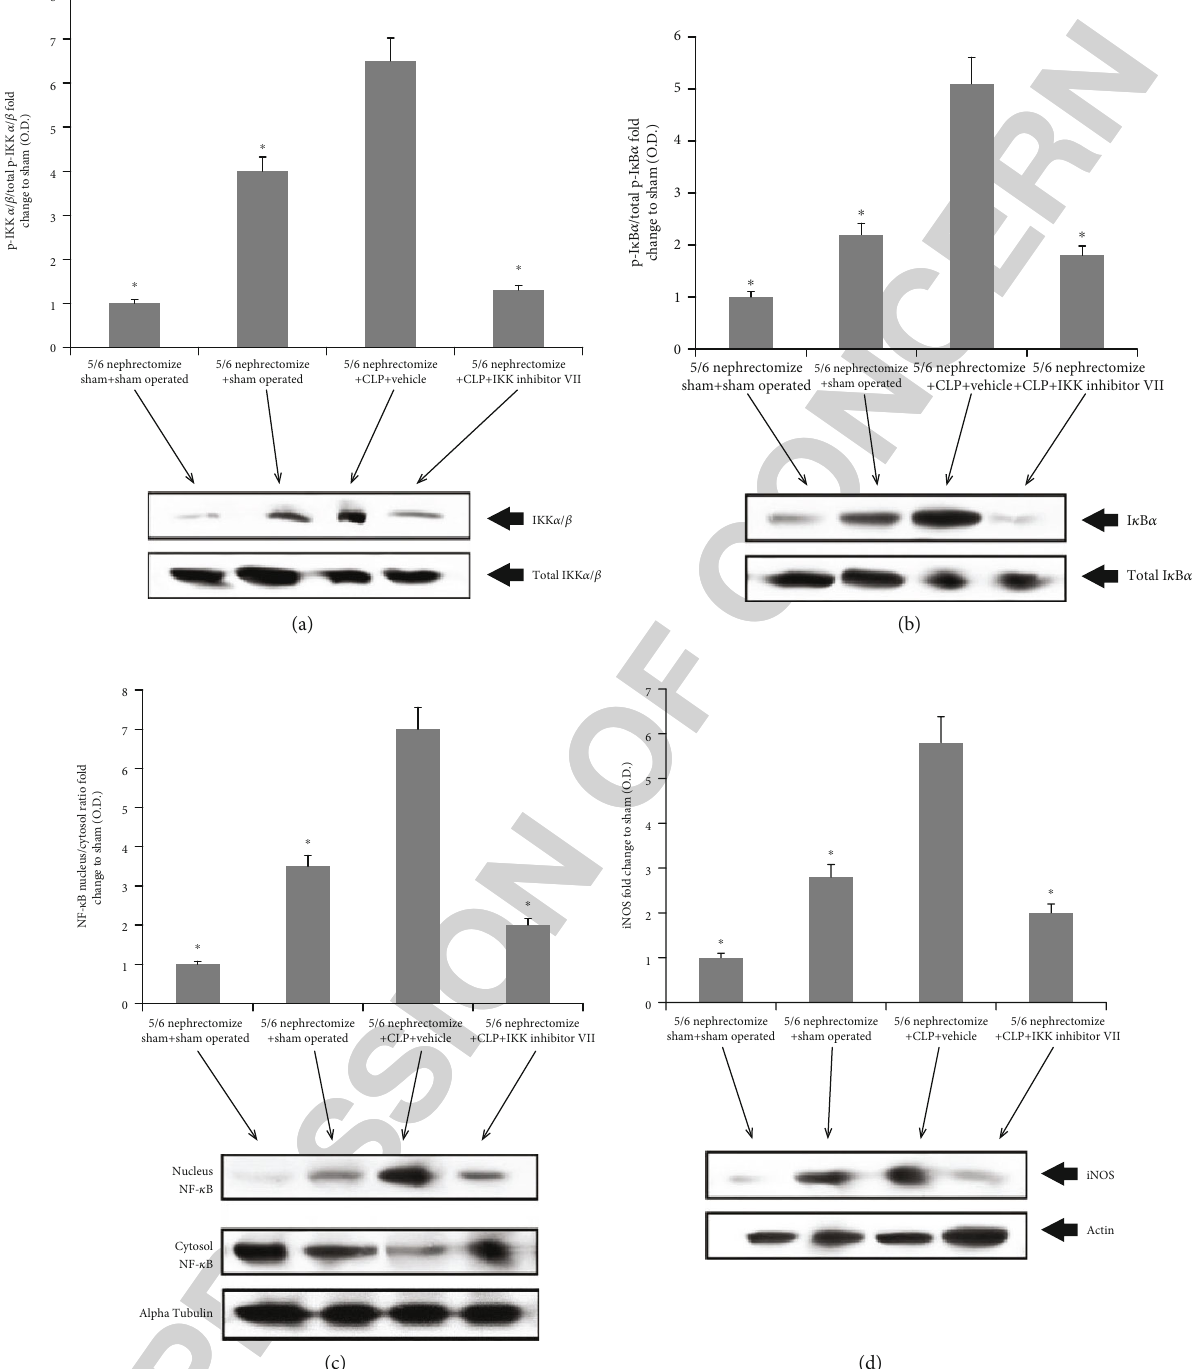
Figure 8: Blockade of IKK provides attenuation and enhances the phosphorylation of IKK α / β and IkB α nuclear translocation of NF- κ B and levels of iNOS in 5/6 nephrectomized CLP mice. The 5/6 nephrectomized mice were subjected to sham surgery, and 5/6 nephrectomized mice were subjected to CLP or sham surgery; after 1 hour post-CLP and 5/6 nephrectomy, the mice were treated with IKK inhibitor VII or vehicle (DMSO). The signaling e ff ects in cardiac tissues were analyzed after 24 hours. Optical density of bands was assessed for the following: (a) phosphorylation of IKK α / β expressed to respective total IKK α / β normalized to respective sham band; (b) optical density of phosphorylated IkB α against total IkB α levels normalized against corresponding sham band; (c) levels of NF- κ B in nuclear and cytosolic fractions presented as nucleus/cytosol ratio; the results were normalized against corresponding sham band; (d) levels of iNOS normalized against actin as loading control. Each experiment was done in triplicate; the data are presented as mean ± SEM . ∗ P < 0 : 05 compared to 5/6 nephrectomized mice, CLP mice, and vehicle-treated